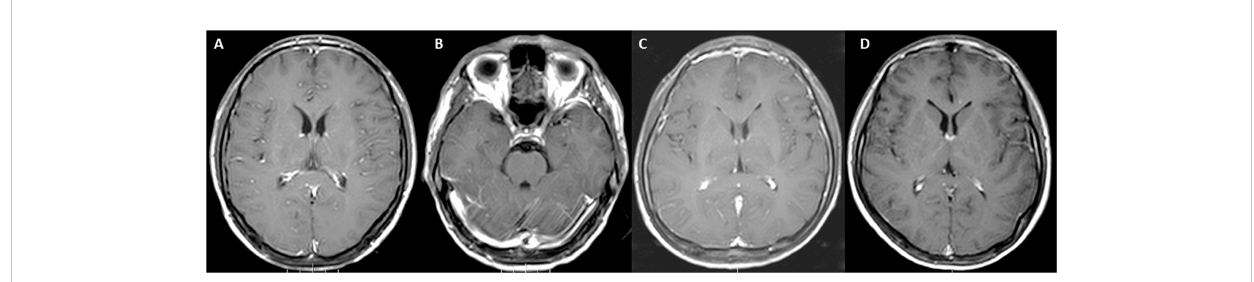
FIGURE 1 Contrast -enhanced brain MRIs of (A, B) case 1 show diffuse enhancement of the leptomeninges without abnormalities in the brain parenchyma. (C) Case 2 and (D) case 3 also show conspicuous and scattered enhancement, respectively of the